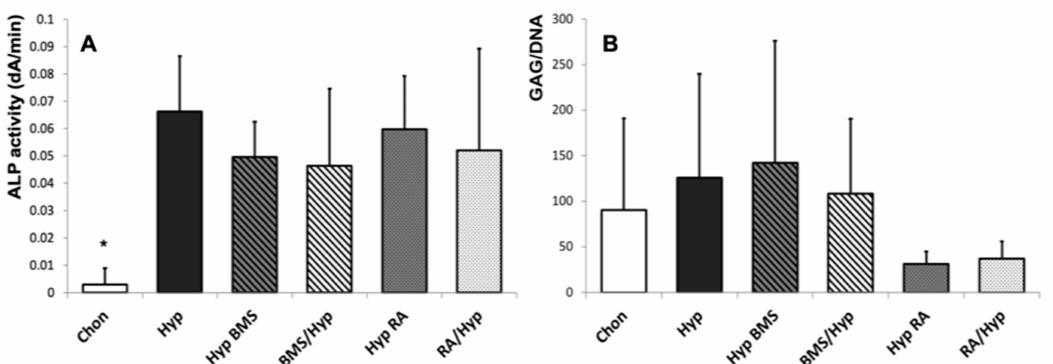
Figure 5. E ff ect of BMS and RA on ALP activity and GAG content. ALP Enzyme activity is measured densitometrically in cell culture supernatants via conversion of an ALP substrate on Day 28 ( A ); GAG content of MSC pellets on Day 28 is normalized to DNA content ( B ). n = 3 MSC donor populations in groups obtaining RA resp. n = 6 populations in other groups. Whiskers represent standard deviations. Significant di ff erences (* p < 0.05) are designated by asterisks. Chon, chondrogenic control group; Hyp, hypertrophic control group; Hyp BMS, hypertrophic group with late BMS treatment; BMS / Hyp, hypertrophic group with early BMS treatment; Hyp RA, hypertrophic group with late retinoic acid treatment; RA / Hyp, hypertrophic group with early retinoic acid